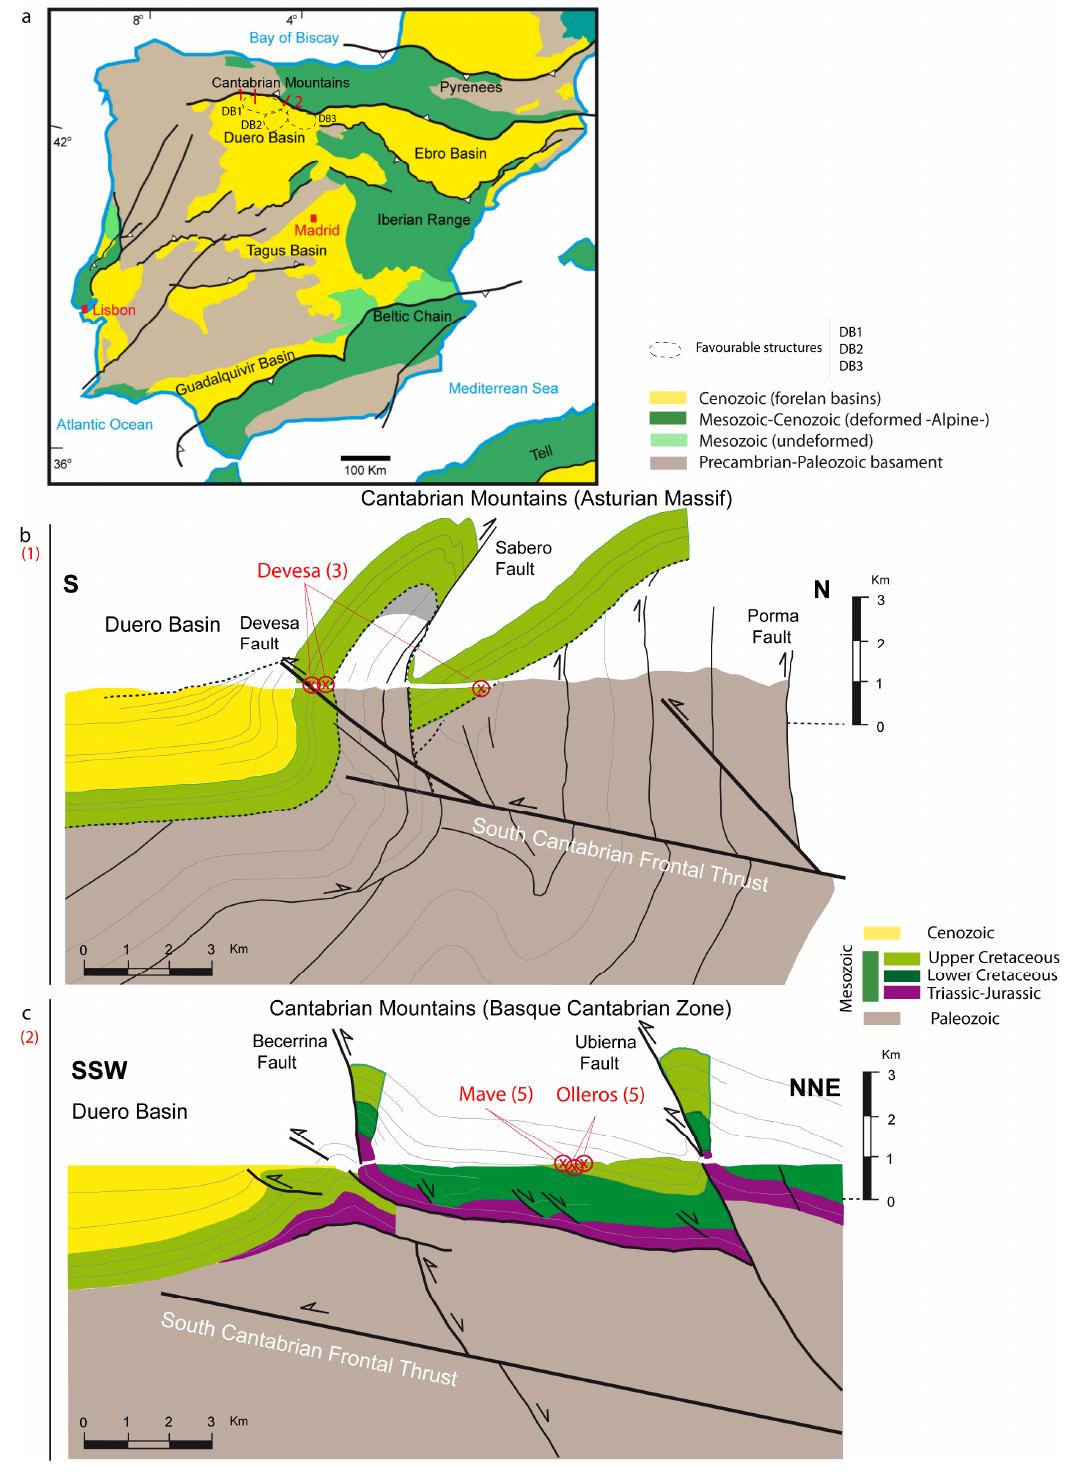
Figure 1. ( a ) Location of study areas with basic geological information: sampling areas Devesa (1) and Olleros-Mave (2) and favorable structures for CO 2 storage [16] ; ( b ) Geological cross-section along the Devesa study area showing the positions of the sampling sites (Devesa 1 to 3); ( c ) Geological cross-section along the Olleros-Mave study area showing the positions of the sampling sites (Olleros 1 to 5 and Mave 1 to 5). Modified from [7].